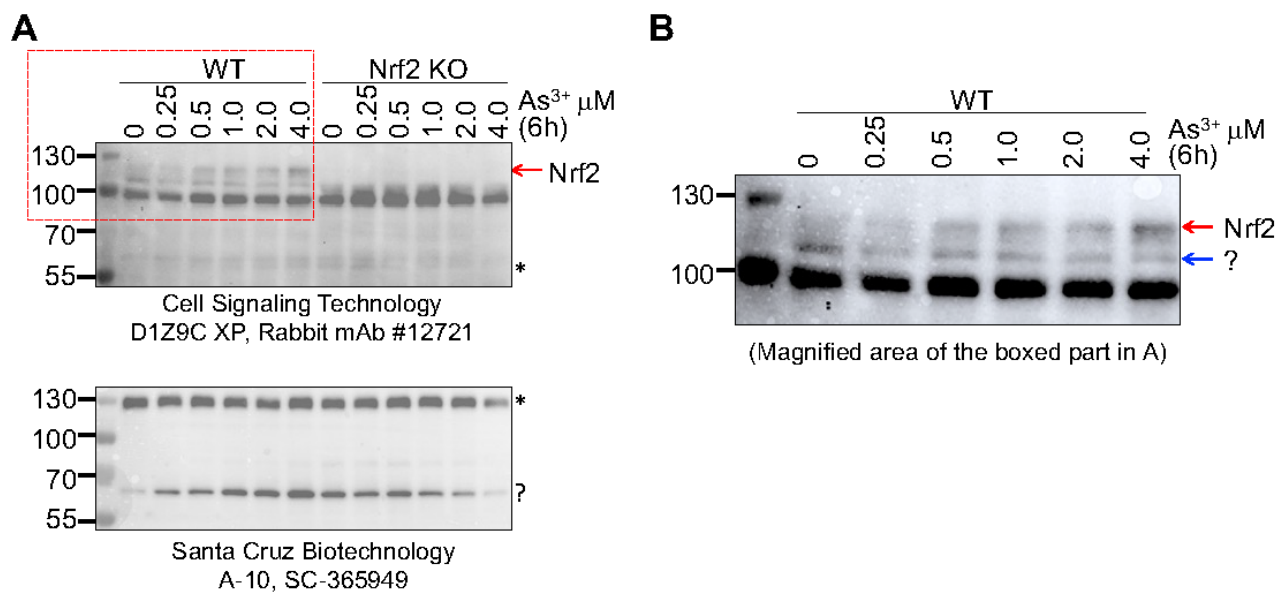
Figure 8. Specificity analysis of the anti-Nrf2 antibodies from different commercial sources. ( A ) The WT and Nrf2 KO cells were treated with the indicated concentrations of arsenic (As 3+ ) for 6h followed by immunoblotting using D1Z9C antibody (top) and SC-365949 antibody (bottom), respectively. (The D1Z9C antibody had shown nearly identical specificity with the Abcam62352/EP1808Y antibody). The authentic Nrf2 band is marked by a red arrow. Asterisks and question mark denote the unknown characteristics of these protein bands. ( B ) Magnified potion of the top left panel in A to show the duplex of the Nrf2 band.